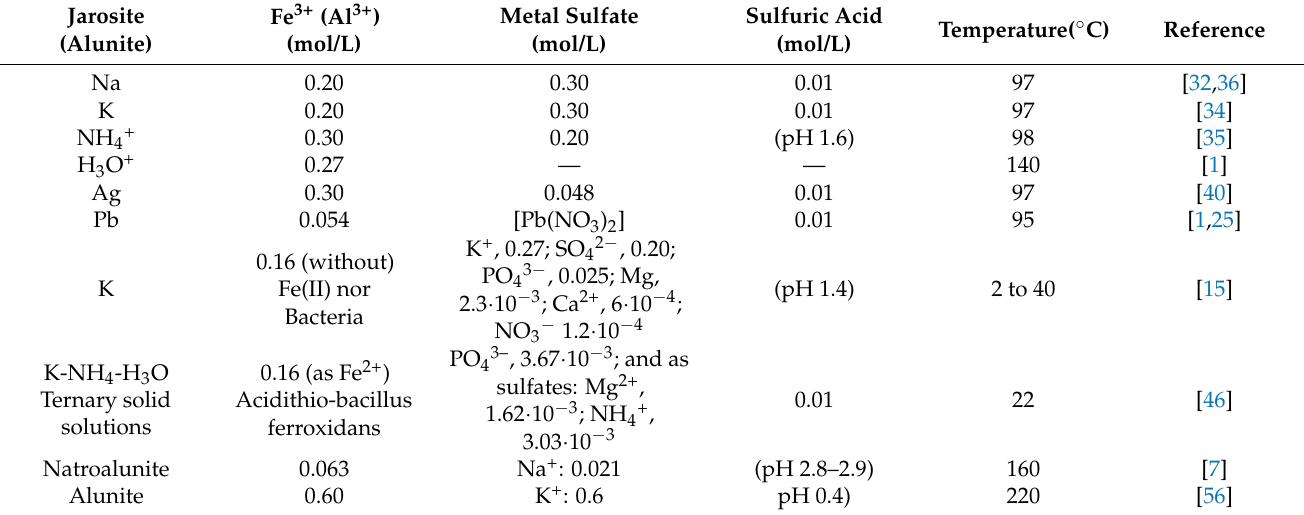
Table 3. Summary of experimental conditions of synthesis of